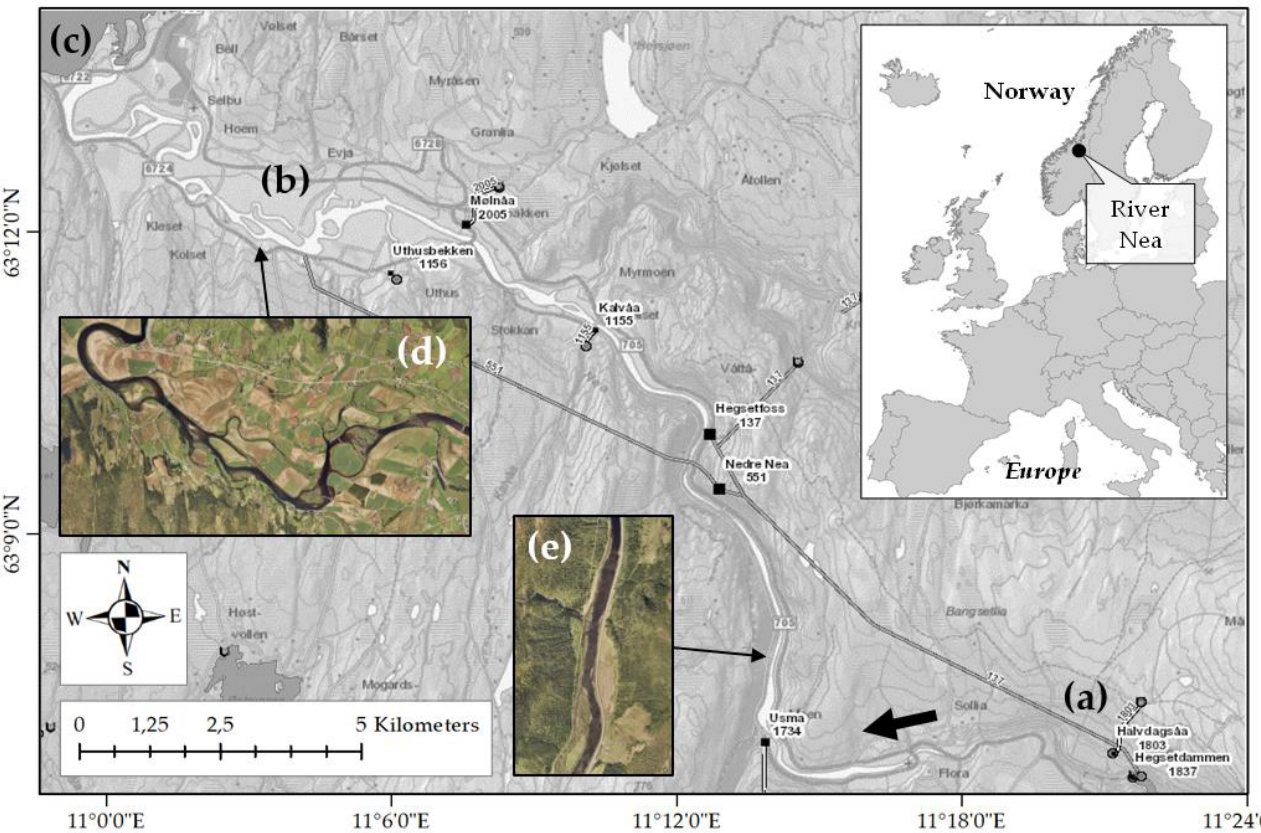
Figure 1. Nea River outline (main picture, in white) in Central Norway (upper-left picture), where ( a ) is the upstream part of the bypass section/dam location, ( b ) is the downstream part of the bypass section/hydropower plant outlet, and ( c ) is lake Selbusjøen. The surrounding landscape is dominated by floodplain agriculture in the lower parts ( d ) and a steep valley in the upper part ( e ). The thick, black arrow indicates flow direction. Straight lines are water transfer tunnels and outlined names are hydropower plants. © Kartverket, Geovekst.